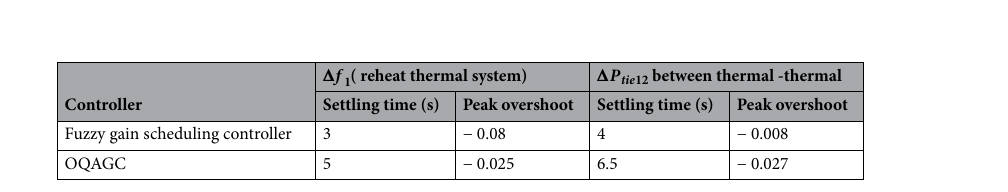
Table 8. Comparative study of overshoot and settling time for sensitivity analysis 57